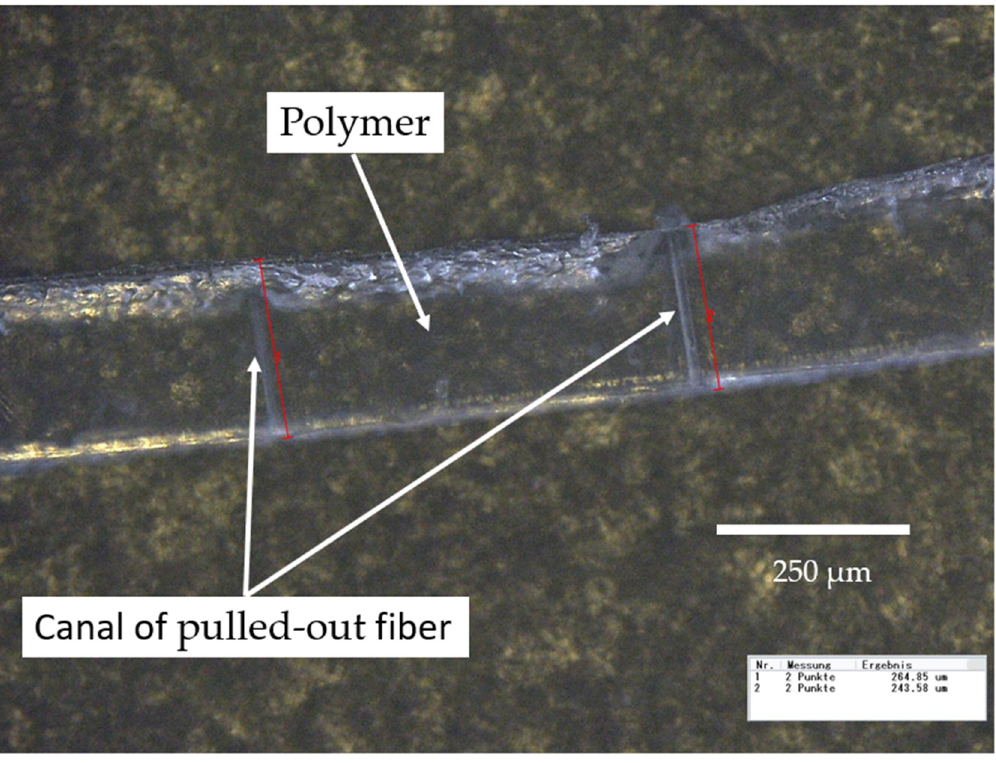
Figure 5. Image of polymer film with canals of pulled-out fiber.